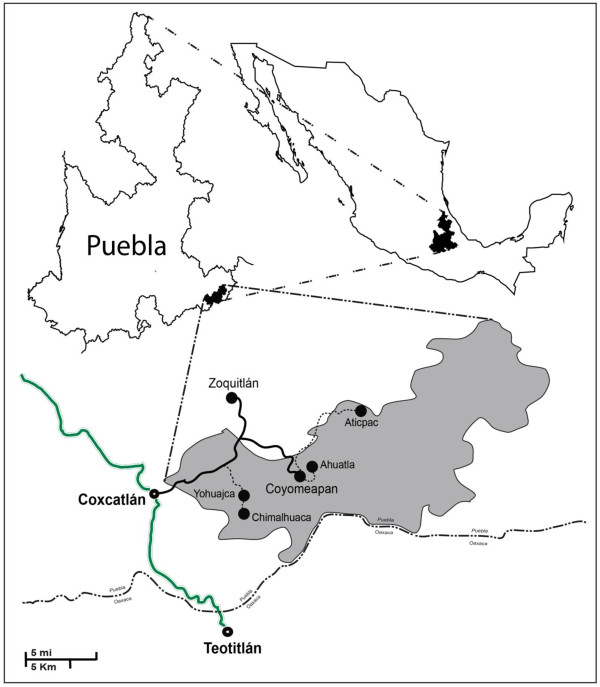
Study area. Location of municipality of Santa María Coyomeapan and the villages studied in the highlands of the Tehuacán Valley, central Mexico.